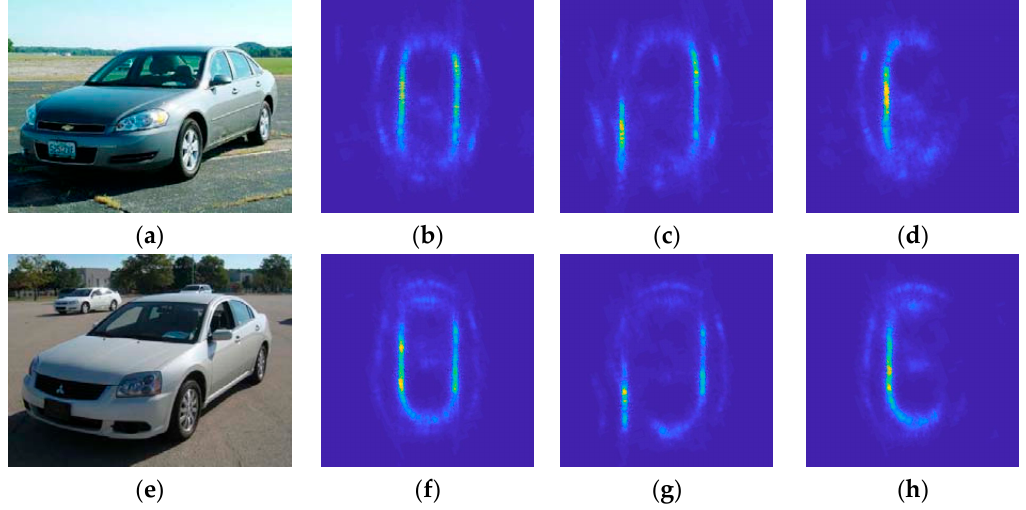
Figure 11. The accuracy of different models changing with the size of the image at β = 0.8. ( a ) The accuracy of the test set; ( b ) The accuracy of the training set; and, ( c ) The accuracy of all images. Electronics 2019 , 8 , x FOR PEER REVIEW